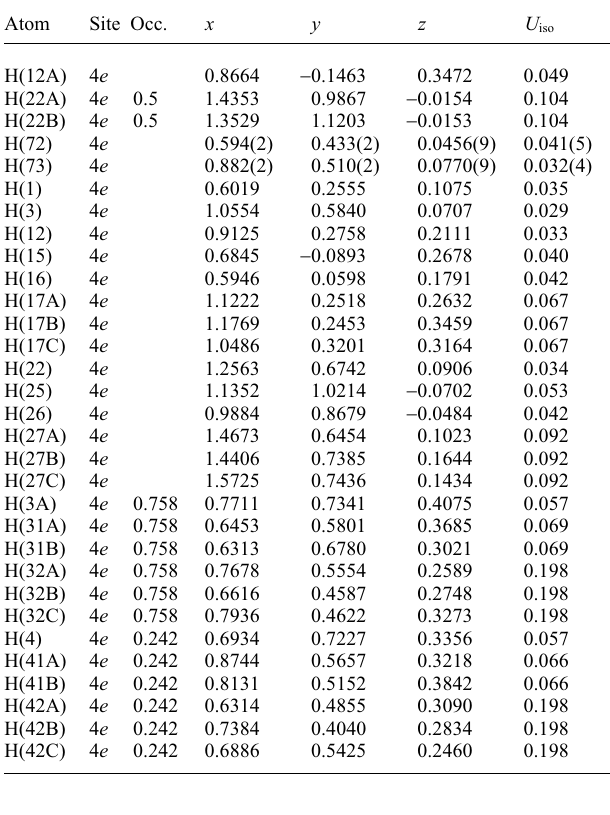
Table 2. Atomic coordinates and displacement parameters (in Å 2 ) .